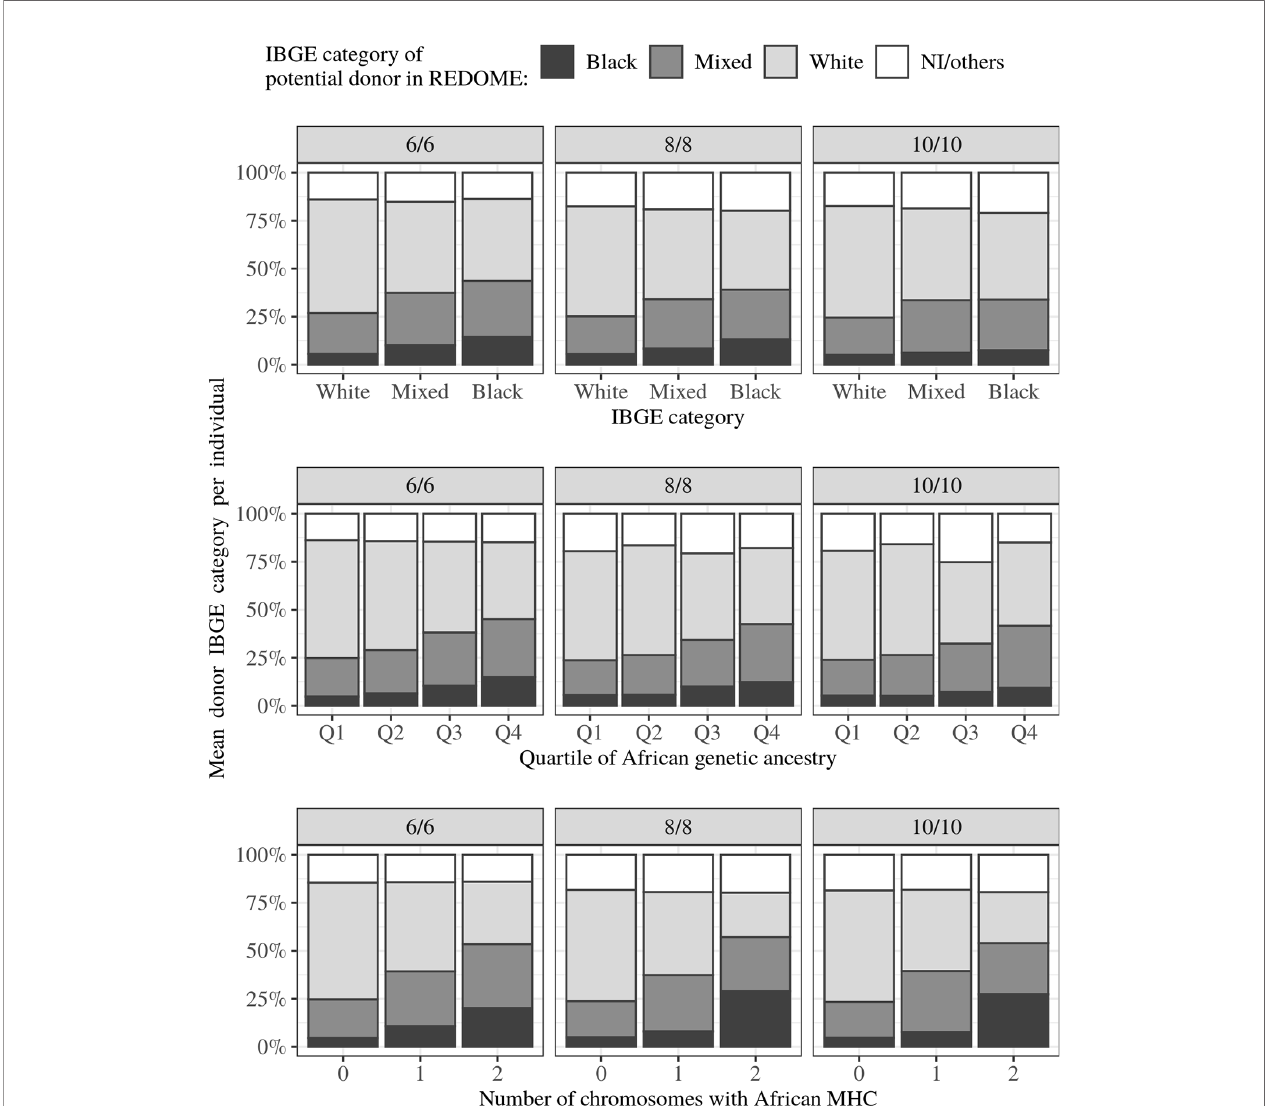
FIGURE 4 | Mean frequency of Brazilian Institute of Geography and Statistics (IBGE) category of the potential donors for individuals in different IBGE categories, African ancestry quartiles, or with different numbers of chromosomes with African MHC. For each individual we calculate the average IBGE category of his/her potential donors, then for each category or genetic ancestry group we computed the group-level average (average of individual averages). Individuals who are “ Black ” or have more African genetic ancestry fi nd proportionately more donors in the same